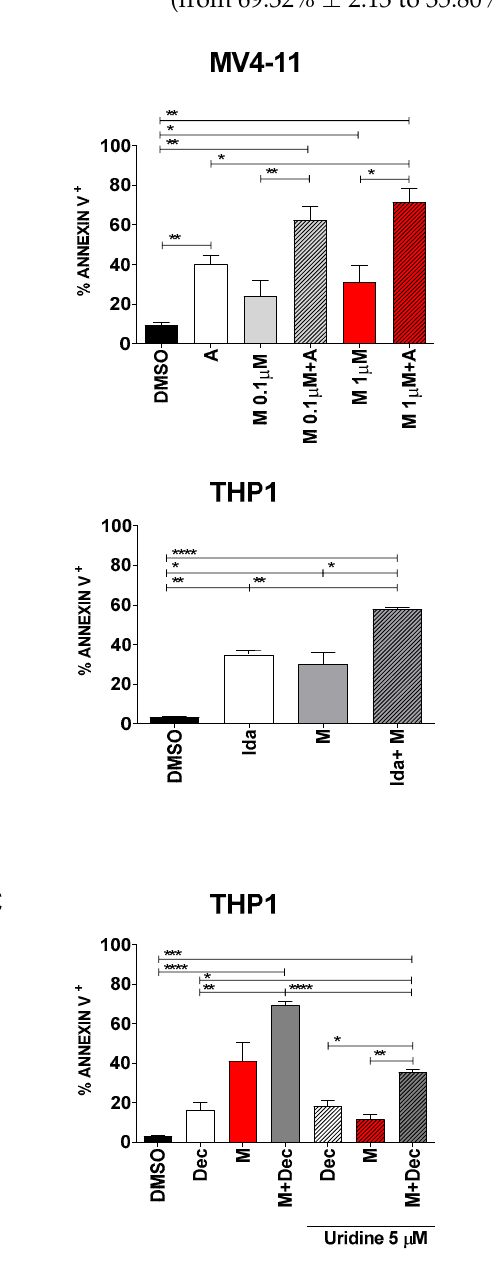
Figure 5. The combination of MEDS433 with classical antileukemic agents results in near-additive effects. ( A ) Apoptosis induced by MEDS433, Ara-C and their combination on MV4-11 (left panel, n = 4) and THP1 (right panel, n = 3) cells. ( B ) Apoptotic rate (left panel) and cell viability (right panel) of THP1 cells treated with MEDS433, idarubicin or both ( n = 3). ( C ) Apoptotic rate (left panel, n = 3) and cell viability (right panel, n = 3) of THP1 cells treated with decitabine, MEDS433 or both, with or without physiological levels of uridine (5 µ M). If not otherwise specified, MEDS433 was utilized at 0.1 µ M. Apoptosis and cell counts were evaluated after 3 days of treatment. DMSO: dimethyl sulfoxide. M: MEDS433. A: Ara-C. Ida: idarubicin. Dec: decitabine. Statistical significance: Anova/Tukey, * p < 0.05; ** p < 0.01; *** p < 0.001; **** p <